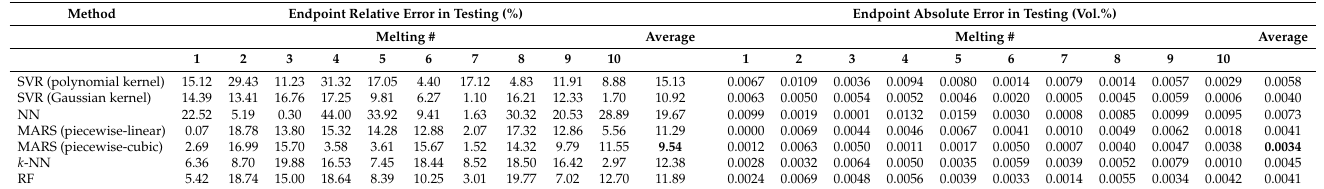
Table 7. Absolute and relative errors on selected meltings in carbon prediction based on static data.